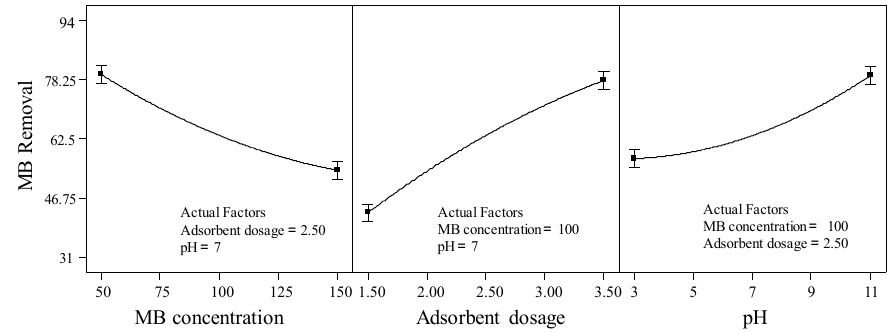
Fig. 8: Main effects of each variable on MB removal. Fig. 8. Main effects of each variable on MB removal.